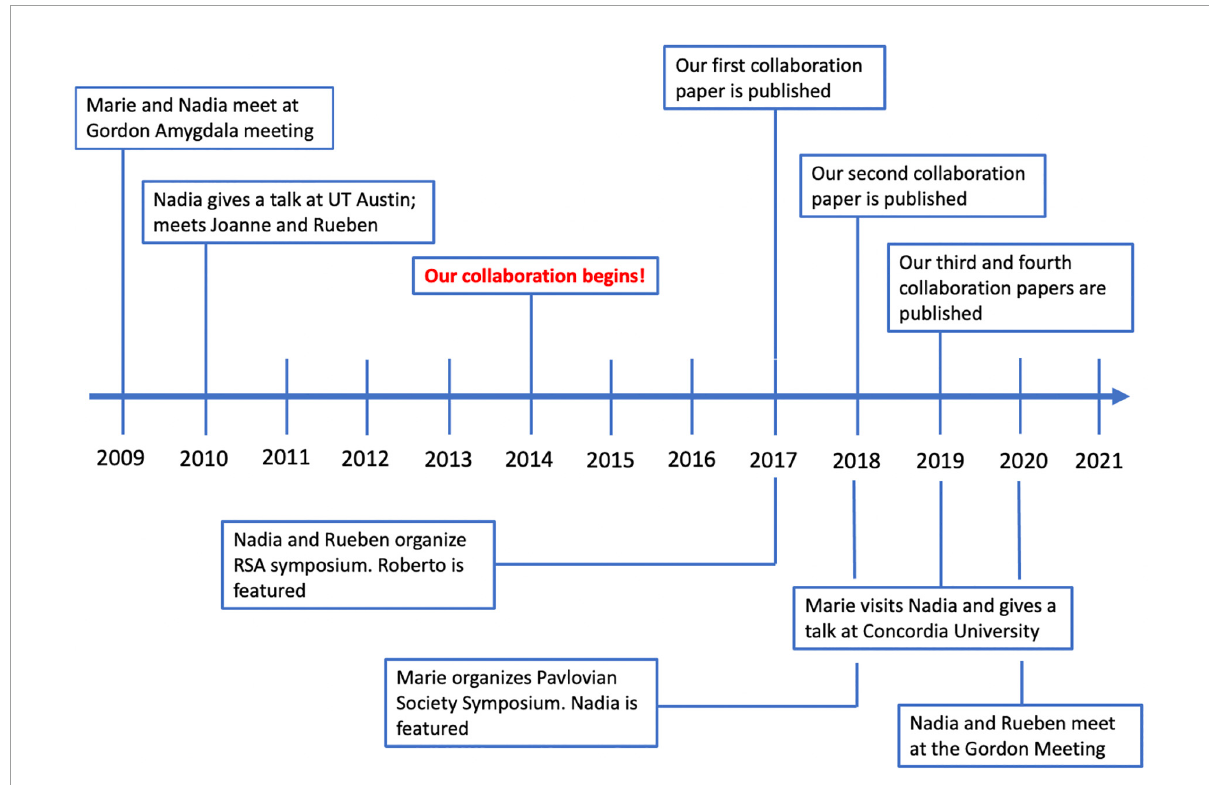
FIGURE1 Timeline of events throughout our friendship and collaboration with